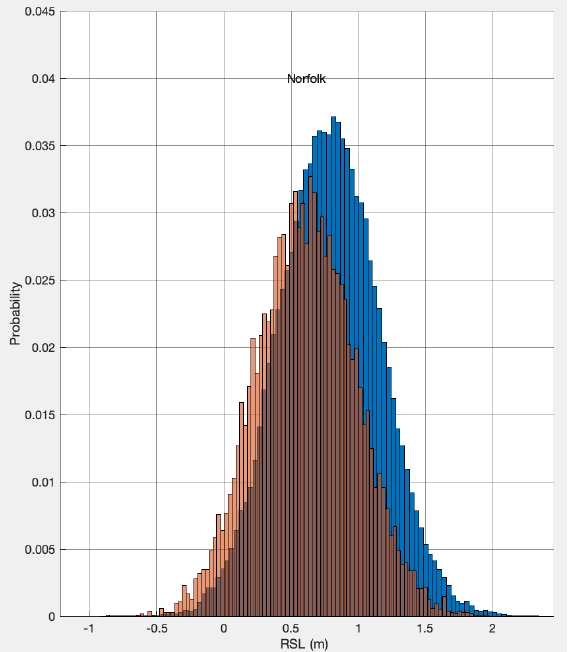
Figure 11. AR5 calibrated projection of RSL for Norfolk (in brown) versus same projection in which GIA statistics from Caron et al. (2018) are used to account for GIA-induced RSL (in blue). Note that both PDF distributions have standard deviations that are essentially identical within 0.4% relative